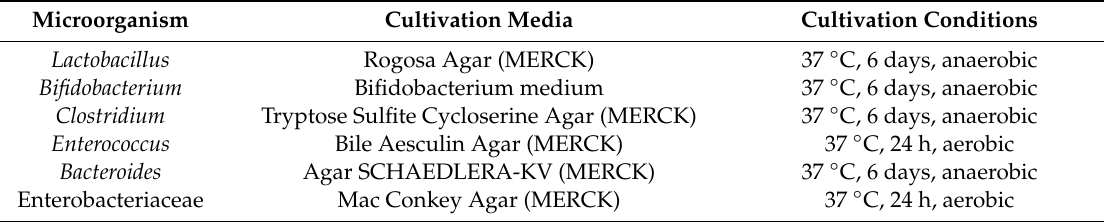
Table 1. Selective media used for the cultivation of intestinal microbes and culture conditions.